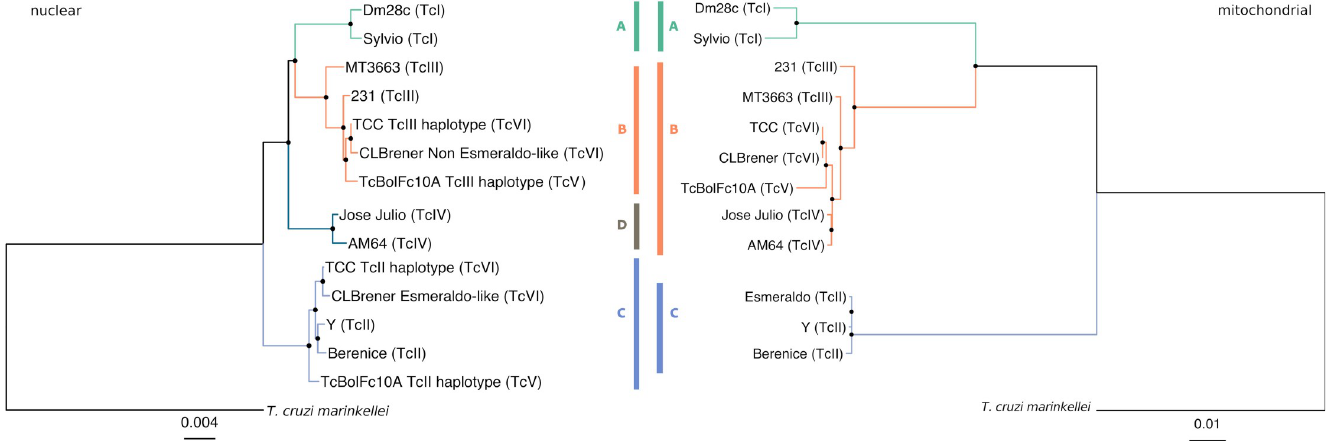
Fig 5. Mitochondrial vs Nuclear phylogenies. A. Nuclear phylogenetic maximum likelihood tree using 85 single-copy genes of 11 strains and T . cruzi marinkellei as outgroup. B. Mitochondrial (coding region) phylogenetic maximum likelihood tree corresponding to the same 12 strains. Nodes with bootstrap value higher than 0.9 are depicted with a black dot on the